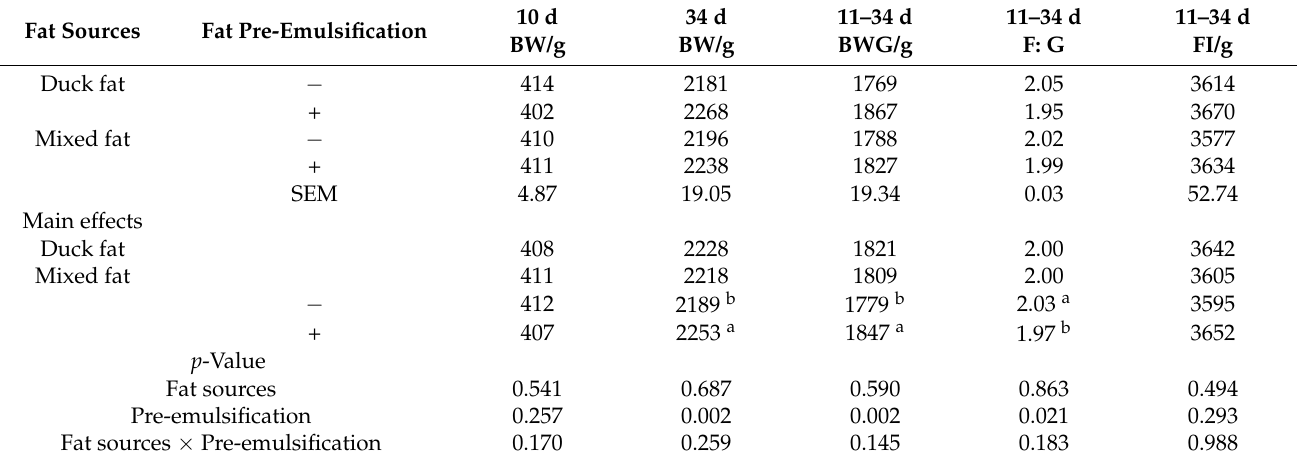
Table 3. Effects of fat sources and pre-emulsification on growth performance of ducks 1,2